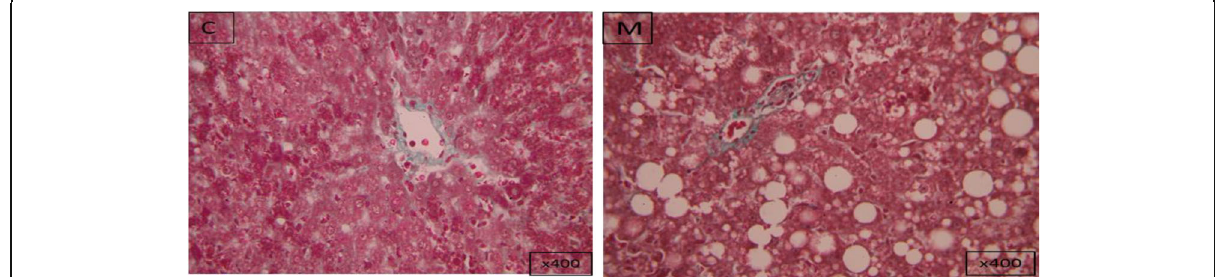
Fig. 7 Liver tissue photomicrograph of control (C) and metabolic syndrome (M) groups after 8 weeks